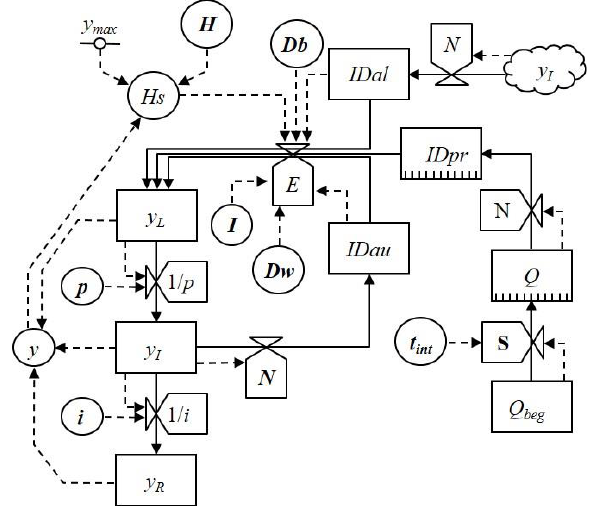
Figure 1. Relational diagram of the model simulating plant disease epidemics. The diagram is drawn following Leffelaar and Ferrari [16]: boxes are state variables, valves are rates, circles are intermediate variables, the dotted line is a constant, arrows with solid lines indicate flows and directions by which state variables change, and arrows with dotted lines indicate flows of information. Symbols are listed in Table 1. The variables affected by changes in crop management actions are in bold.